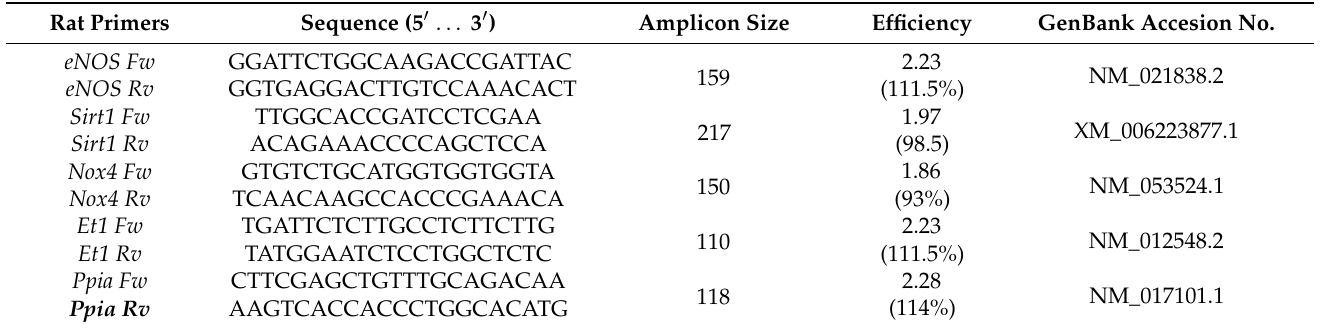
Table 1. Primer list